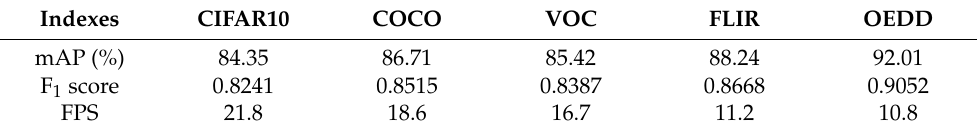
Table 5. Comparison of the detection performance on different datasets with the algorithm we